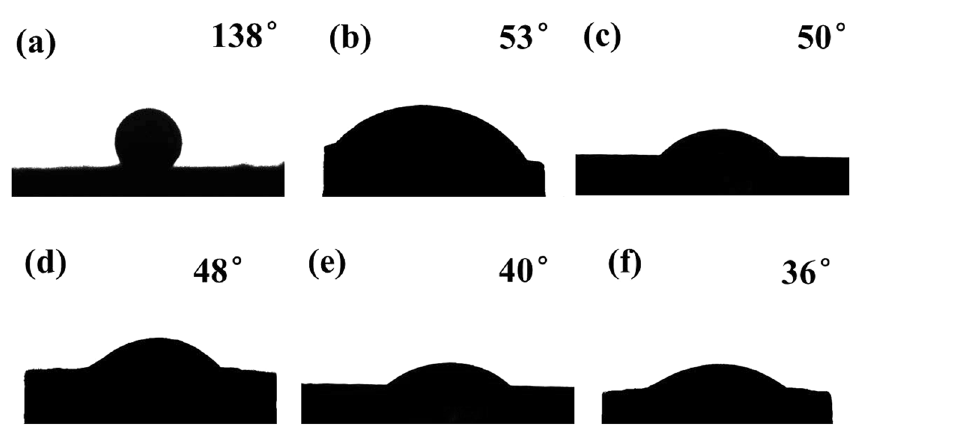
Figure 7. ( a ) Schematic diagram of model and coordinate half system adopted in calculation and residual stress distribution of SiO